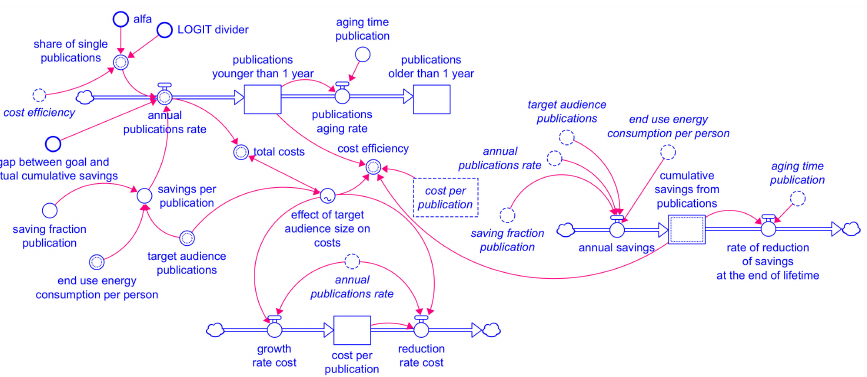
Figure 4. One-time publications in mass media